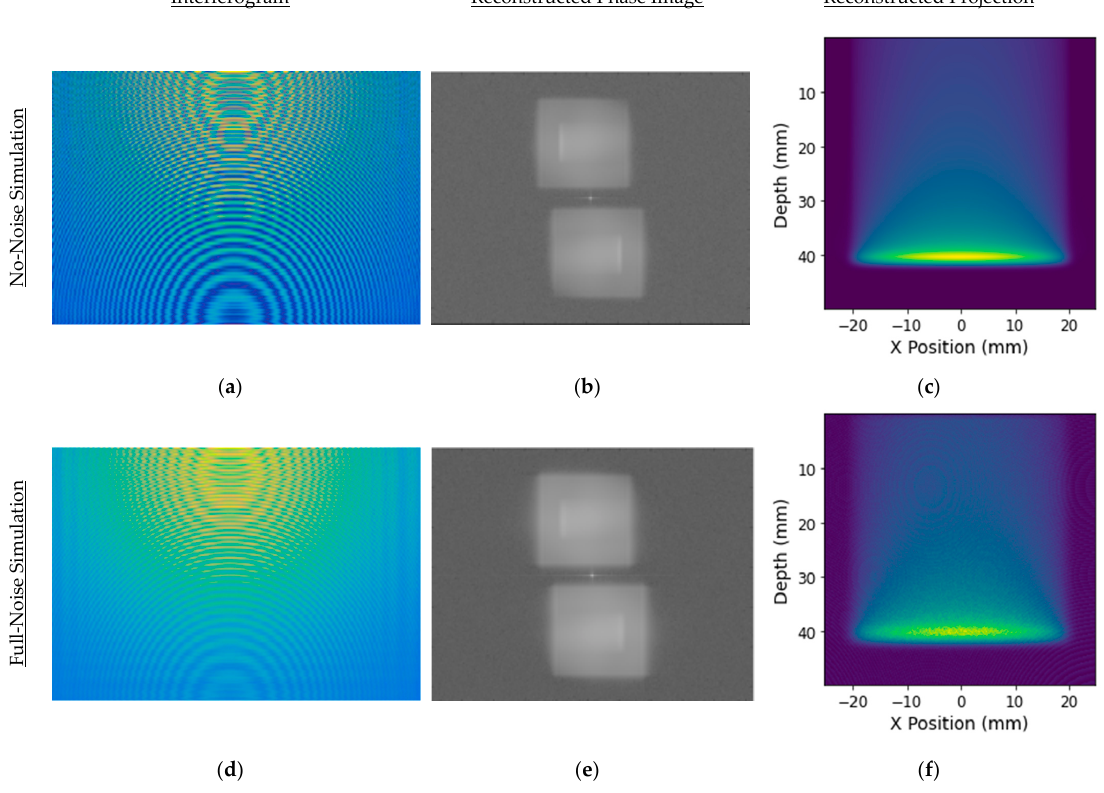
Figure 5. Images generated during the reconstruction of FRED simulations. The top row displays the interferogram ( a ), reconstructed phase image ( b ), and projection image ( c ) for the no-noise 40 mm proton beam simulation. In the bottom row, ( d – f ) display the same images for the full-noise- simulated results.